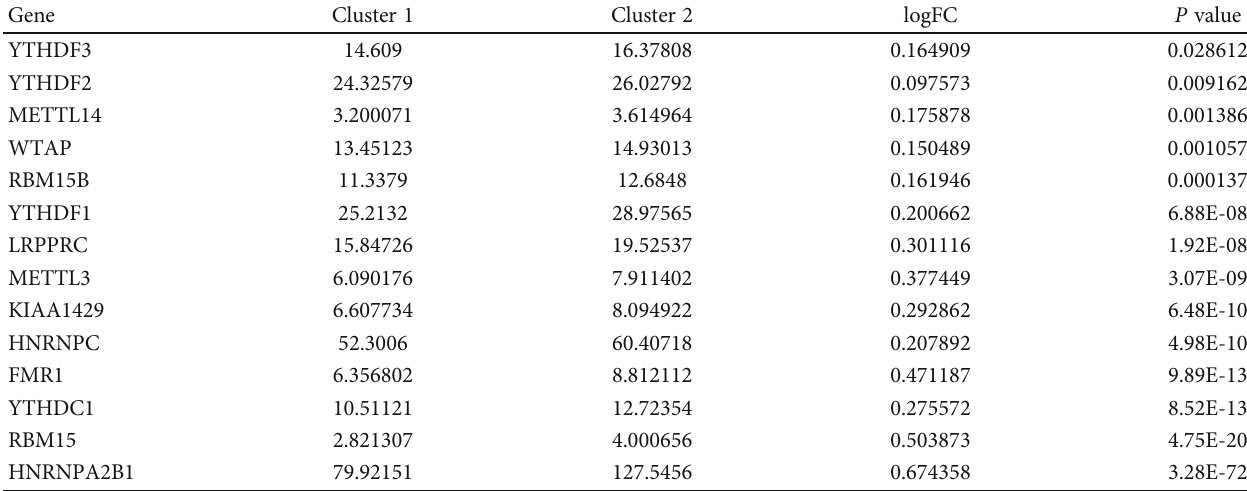
Table 2: Expression levels and di ff erences of 16 M6A methylation regulators in cluster 1 and cluster